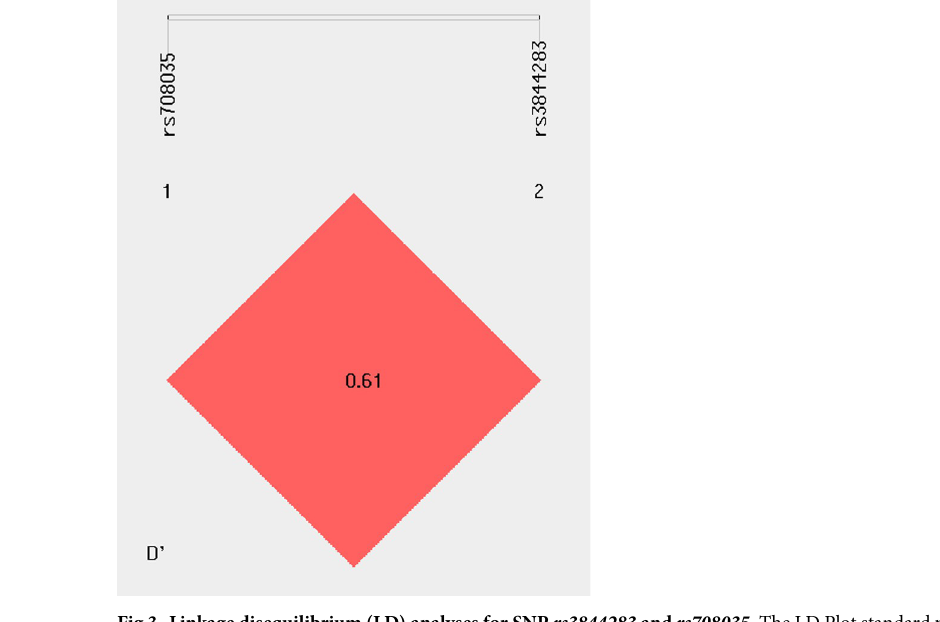
Fig 3. Linkage disequilibrium (LD) analyses for SNP rs3844283 and rs708035 . The LD Plot standard plot which showed 61% linkage disequilibrium among targeted SNPs with R 2 =